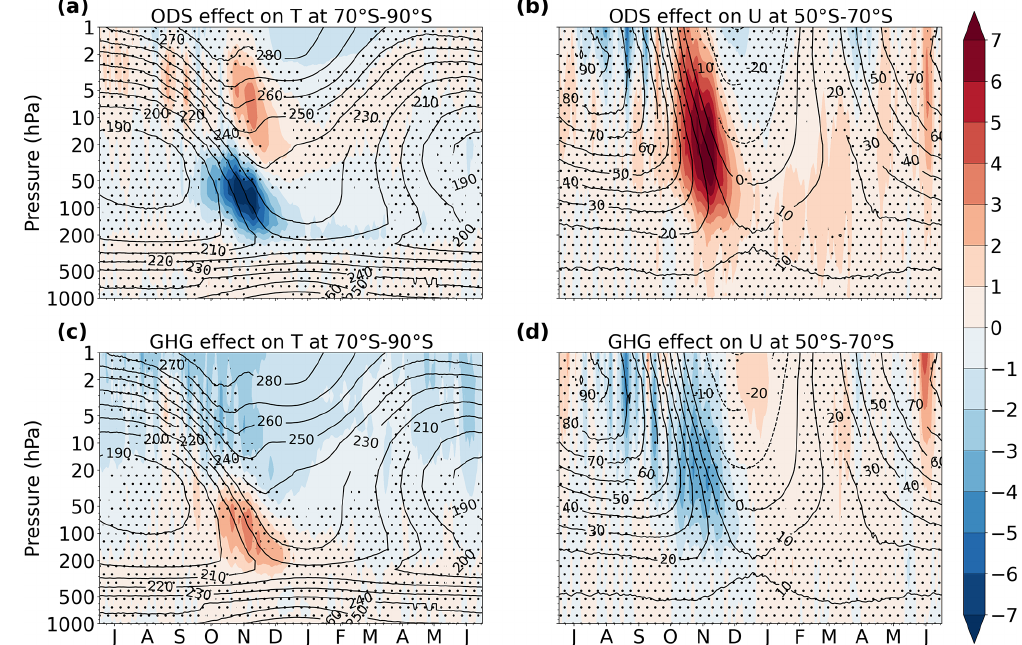
Figure 2. Seasonal cycle of the difference between REF and NoODS (a, b) and between REF and NoGHG (c, d) in the polar cap (70–90 ◦ S) temperature ( a, c ; K) and in the midlatitude (50–70 ◦ S) zonal wind ( b, d ; ms − 1 ) for the period 1978–2002 (color shading). Stippling masks values that are not significant at the 95% confidence interval. Contours show the corresponding climatological temperature and zonal wind from REF. The letter corresponding to each month marks the middle of that